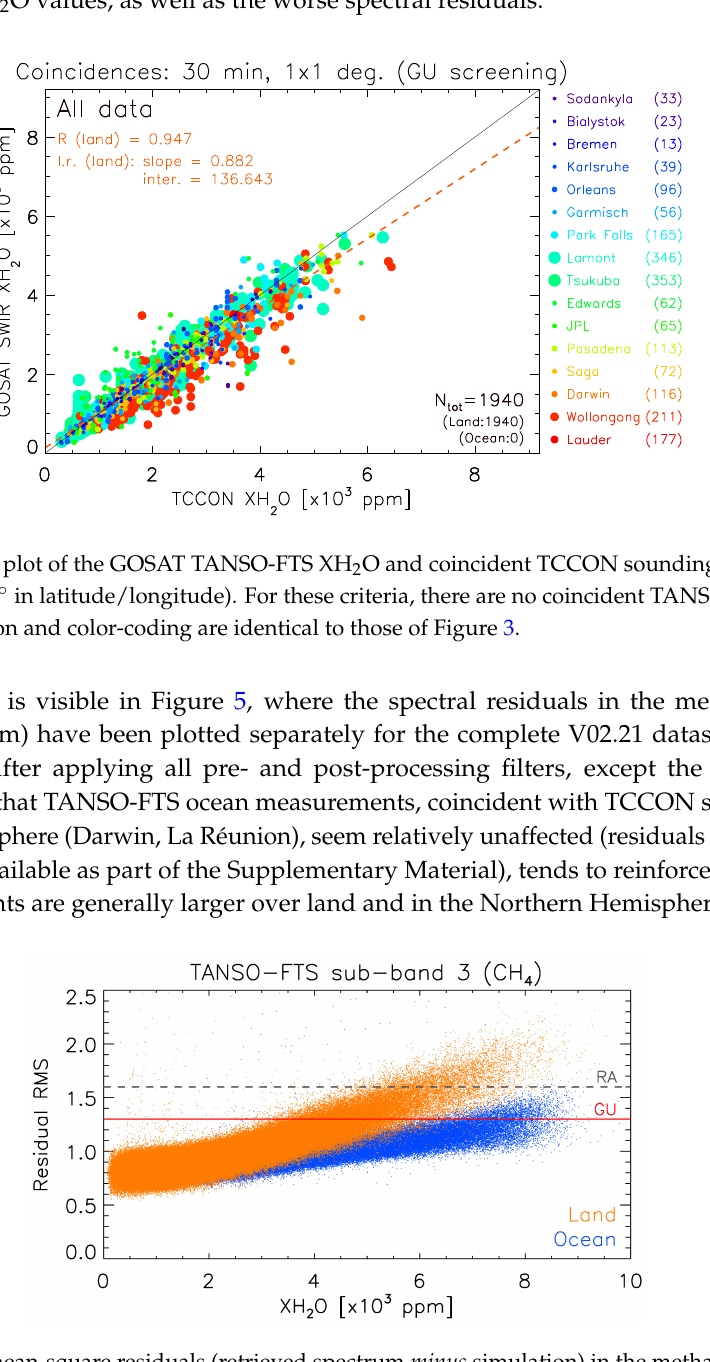
Figure 5. Root-mean-square residuals (retrieved spectrum minus simulation) in the methane sub-band as a function of the retrieved XH 2 O, after applying all filters corresponding to General User (GU) screening, except the RMS filters (Table A1, Appendix A). All successful retrievals for the V02.21 dataset are included. Each dot represents a successful retrieval, in orange and blue for land and ocean measurements, respectively. The filtering thresholds are indicated for the Research Announcement (RA) (dashed grey line) and GU (solid red line) screening